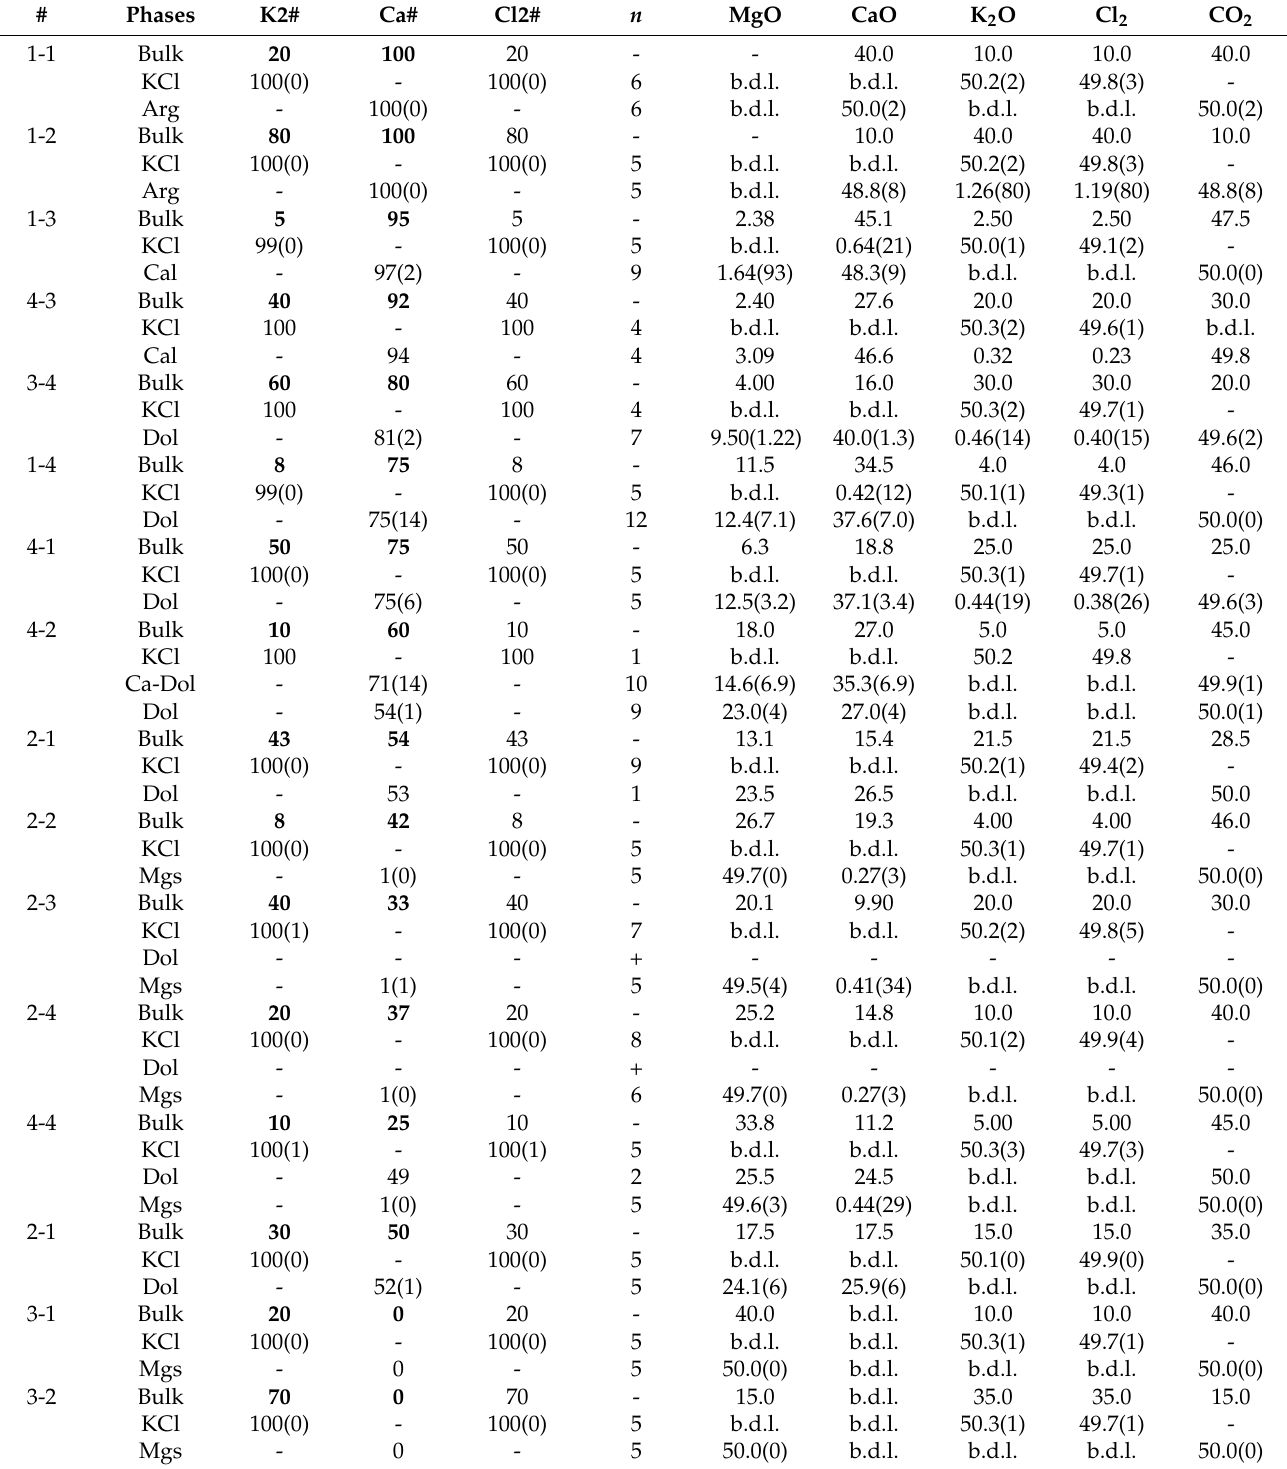
Table 1. Phase compositions (mol%) in run D321 at 900 ◦ C and 72